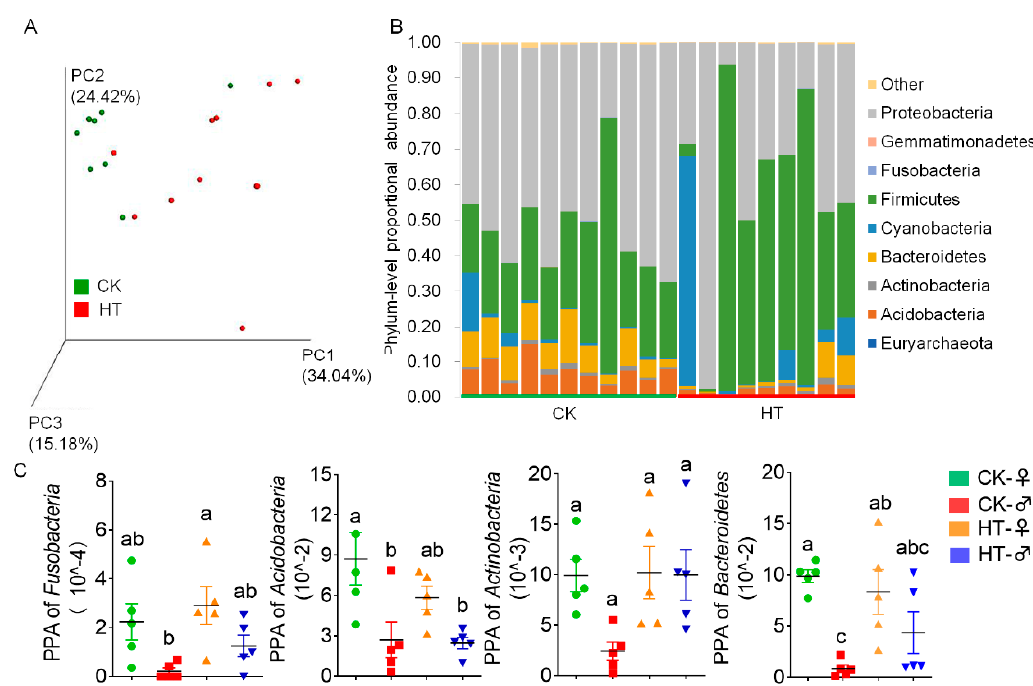
Figure 3. Composition and abundance of gut microbes of silkworm after the high-temperature treatment. ( A ) Analysis of sample principal coordinates. The percentage in the brackets of the coordinate axis represents the proportion of the difference in the original data that can be explained by the corresponding principal coordinate. Principal components (PCs) 1, 2, and 3 are the characteristic values that cause the differences in samples in each group, which are 34.04%, 24.42%, and 15.18%, respectively. ( B ) The gut microbial composition of the sample at the phylum level. ( C ) The abundance of gut microbes of the sample at the phylum level. Bars with different letters are significantly different ( p < 0.05).